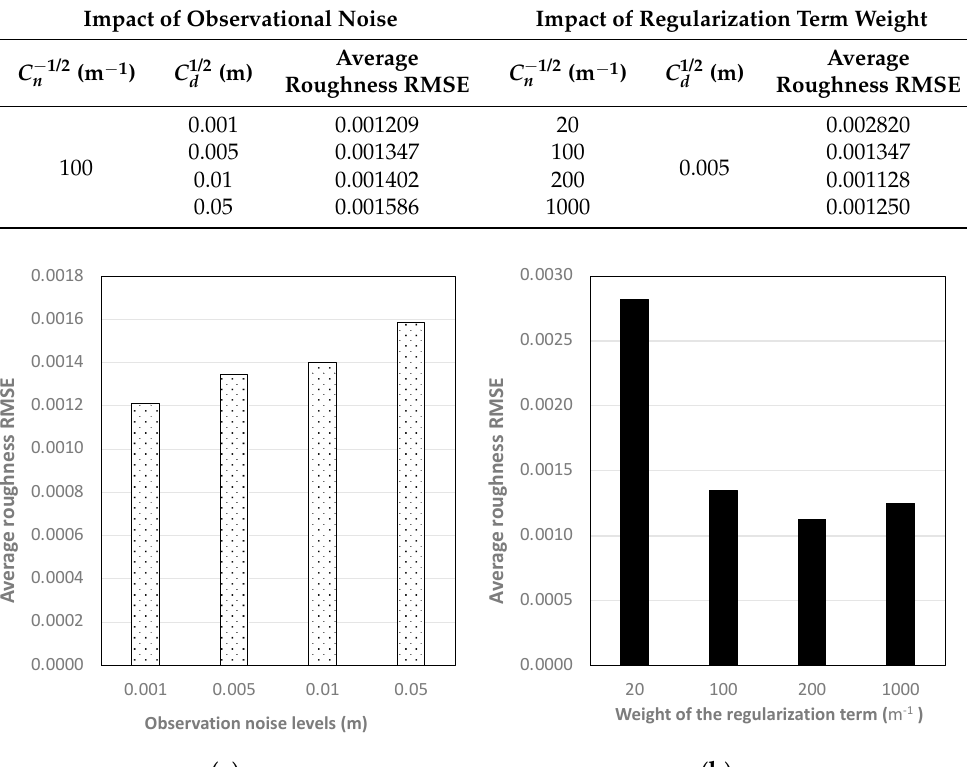
Table 4. Average roughness RMSE with different observational-noise levels and regularization weights.